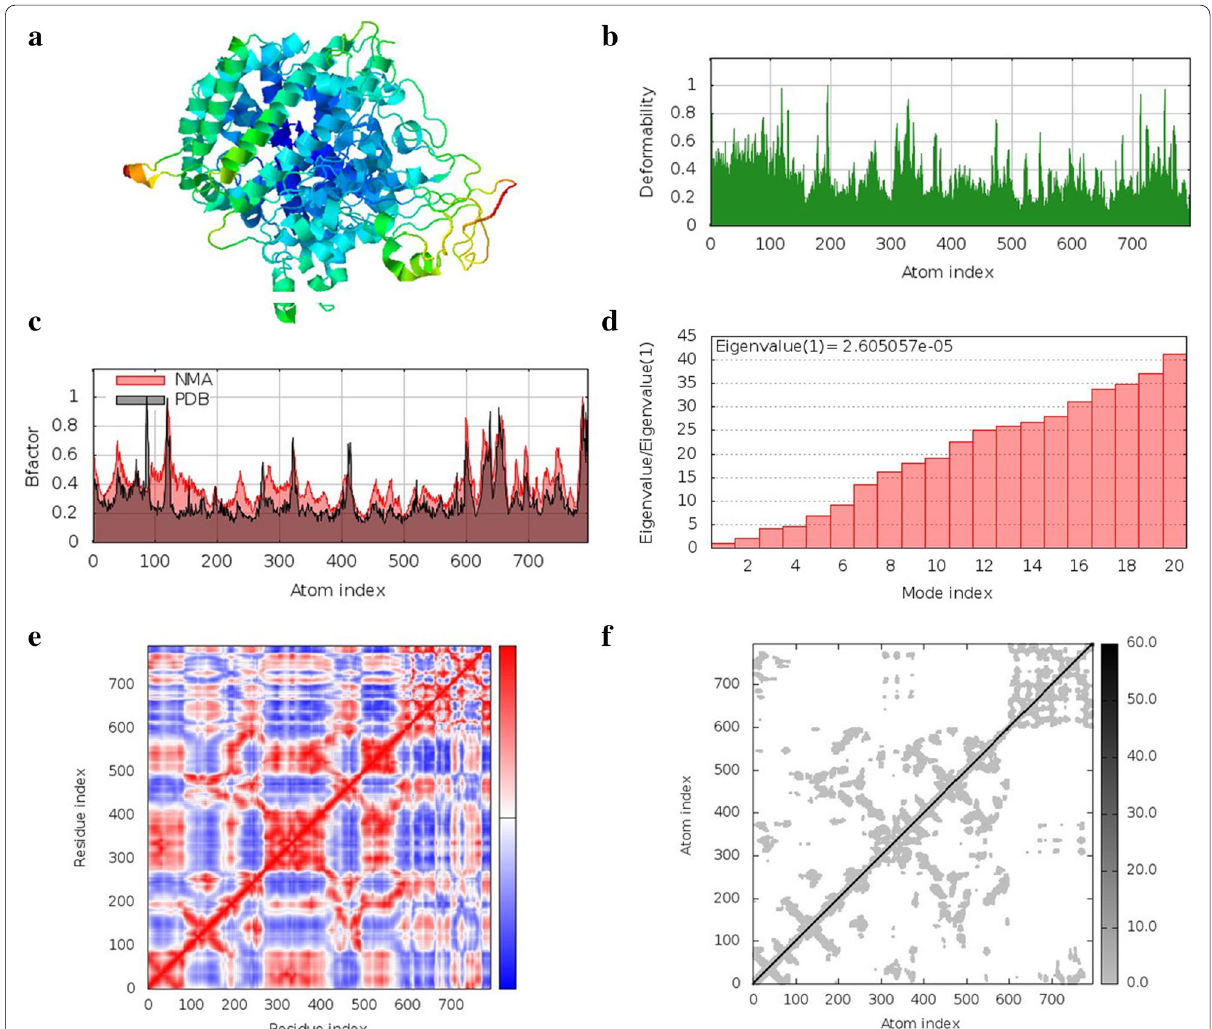
Fig. 8 Normal mode analysis of quercetin 3-[rhamnosyl-(1- > 2)-alpha-L-arabinopyranoside] and spike protein receptor binding domain complex a NMA mobility, b deformity, c B-factor, d eigenvalues, e covariance map, f elastic network of